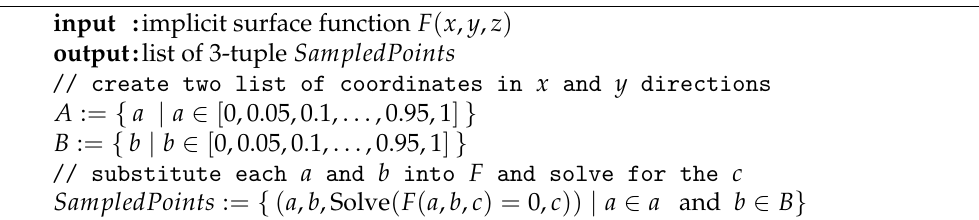
Algorithm 1: Points sampling from an implicit surface F ( x , y , z ) =